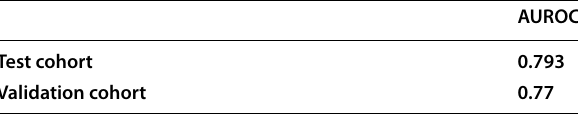
Table 7 AUROC of test and validation